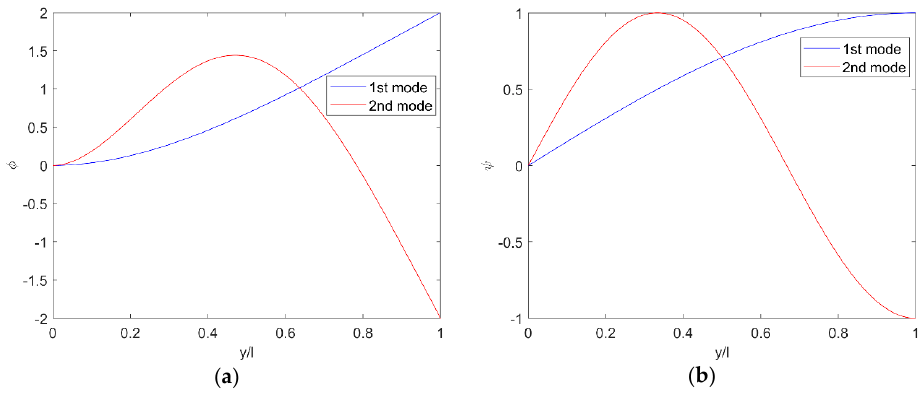
Figure 4. First two bending ( a ) and torsion ( b ) exact natural vibration modes.